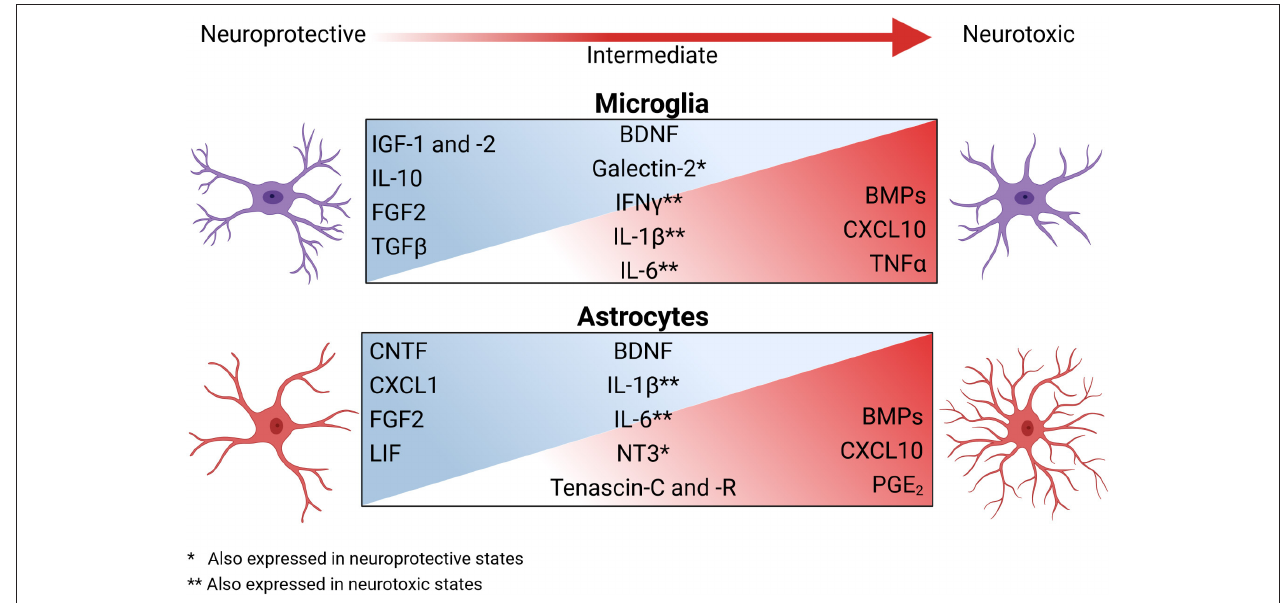
FIGURE 2 | The secretory profiles of glia change across the spectrum of reactive phenotypes and have broad impacts on OPC function during neuroinflammation and neurodegeneration. During homeostasis, astrocytes and microglia interact with other CNS resident cells to help maintain a homeostatic environment via the secretion of trophic factors. During neuroinflammation, the microenvironment changes both cellularly and molecularly to shift the activation state of these glia, inducing a spectrum of glial secretory profiles. Factors secreted during this shift include growth factors, cytokines, survival signals, and ECM modulators. Classically activated microglia and astrocytes are highly inflammatory and significantly contribute to microenvironmental neurotoxicity and inhibit OPCs by secreting bone morphogenic proteins (BMPs), chemokines, cytokines, and prostaglandin E2 (PGE 2 ). As inflammation resolves, the reactive state of microglia and astrocytes again promote the reparative properties of OPCs. Created with